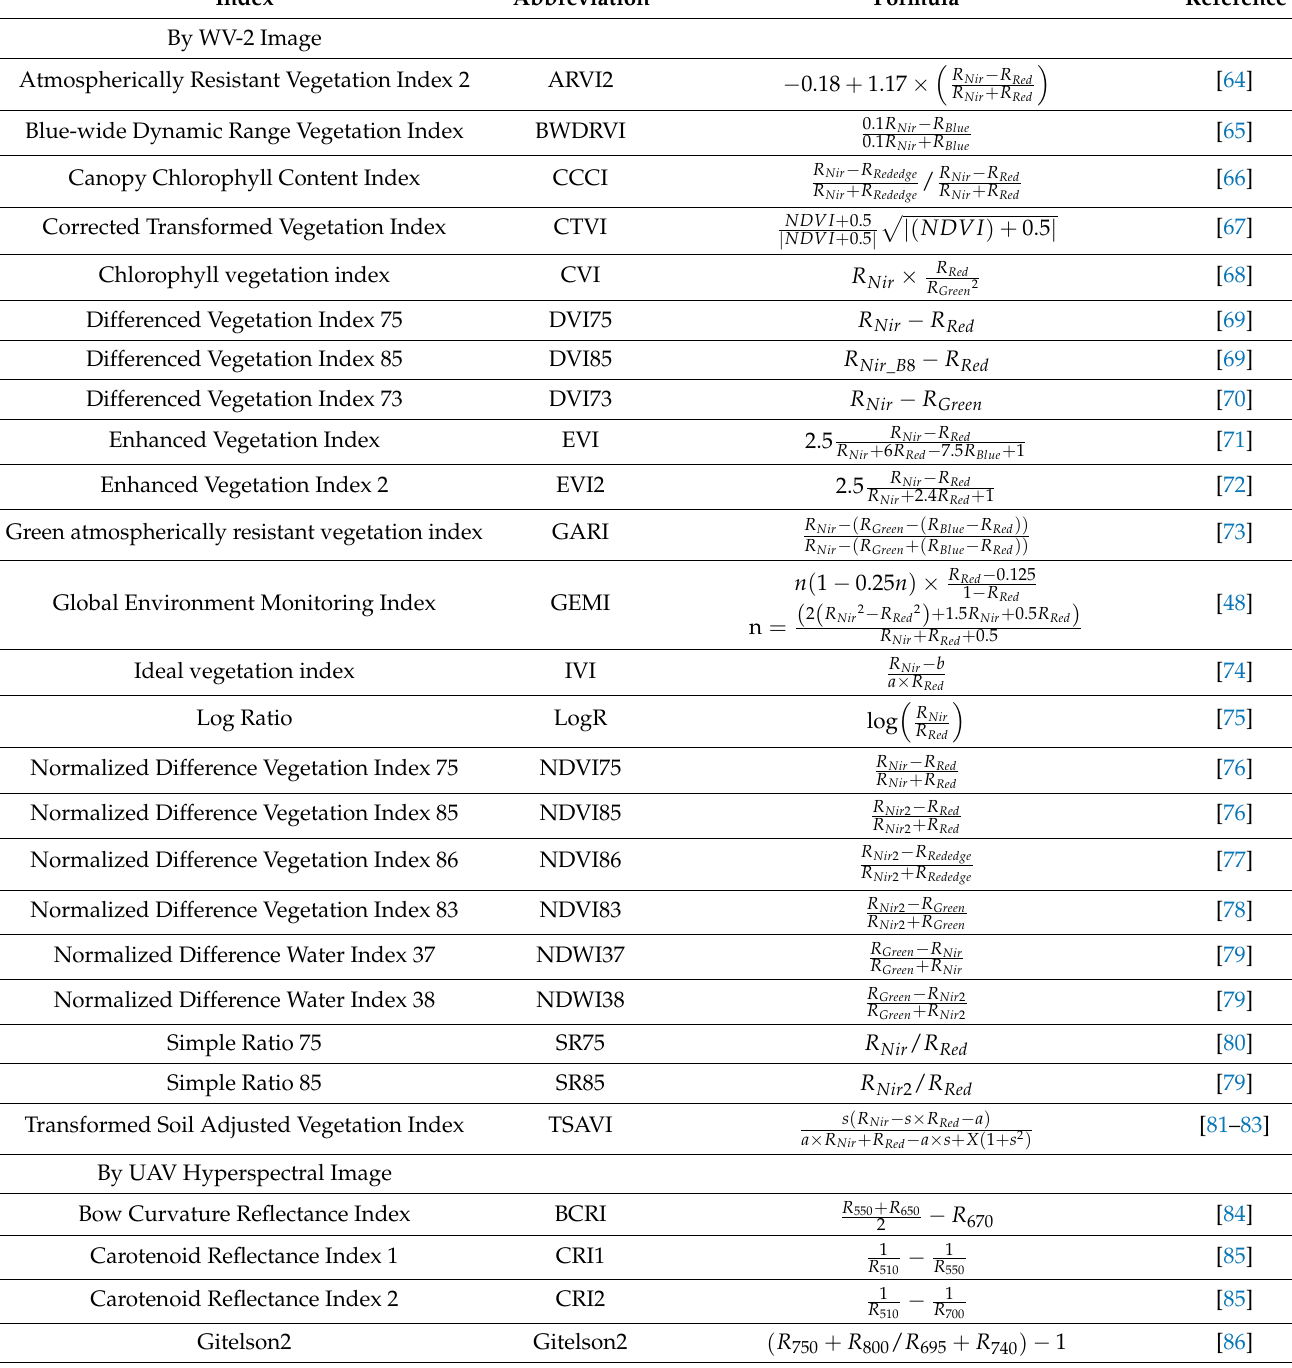
Table A1. Vegetation index extracted for